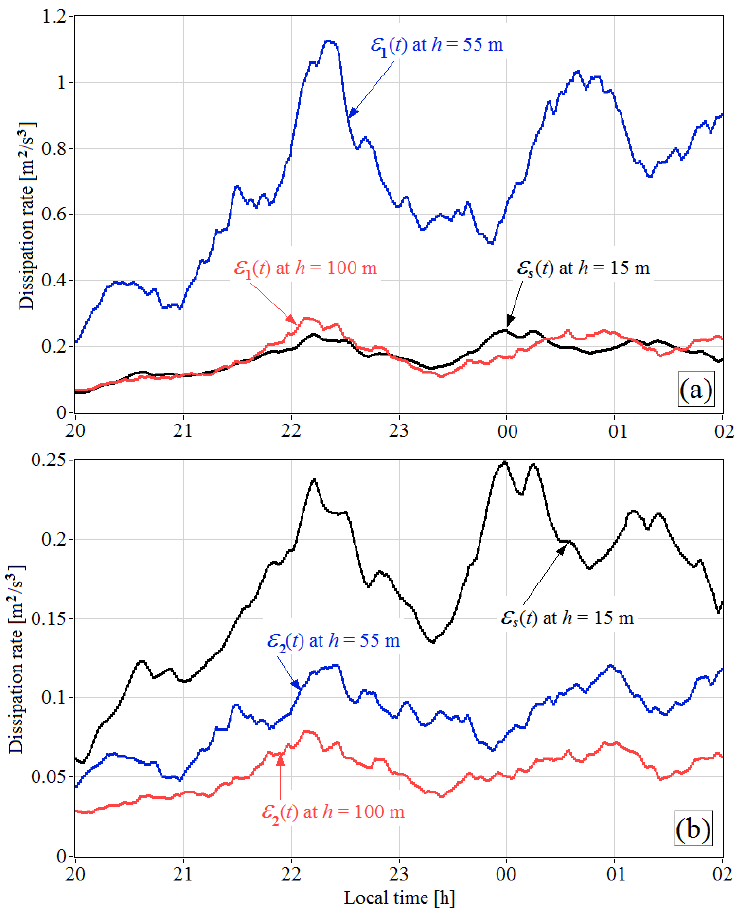
Figure 6. Time series of the turbulent energy dissipation rate as estimated from the data of the sonic anemometer at a height of 15 m (black curves) and the lidar at a height of 55 m (blue curves) and 100 m (red curves). The lidar estimates of the dissipation rate are obtained with Method 1 ( a ) and Method 2 ( b ). The lidar data are taken from Figure 4c,d.